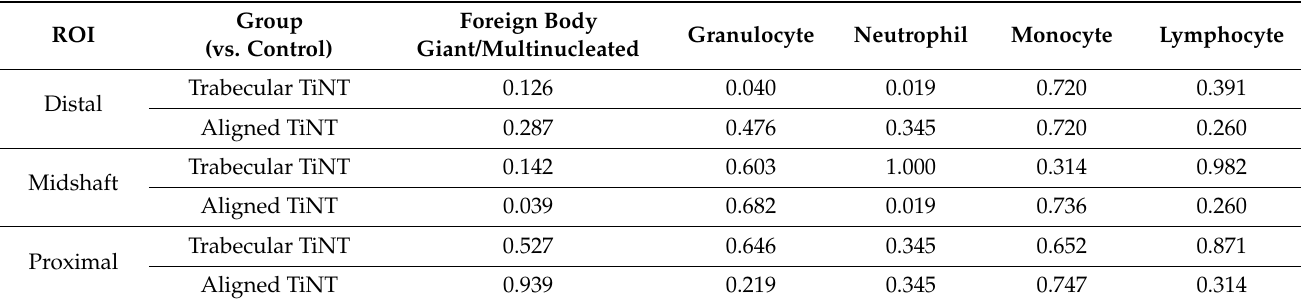
Table 3. Statistical comparisons ( p -values) between implant groups with control of average histologic grade for three regions of interest *.